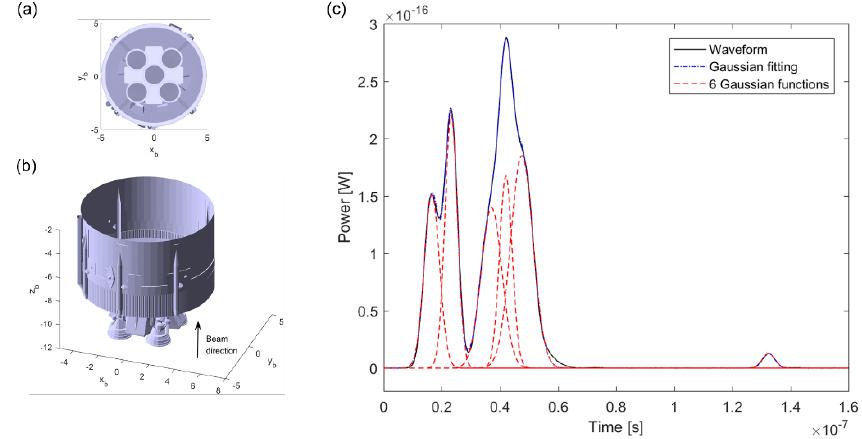
Figure 13. The ( a ) reflected surface, ( b ) orientation of rocket body, and ( c ) the echo waveform and 7 Gaussian functions obtained from the Gaussian decomposition for − 90 ◦ rotation about the y-axis w.r.t. Figure